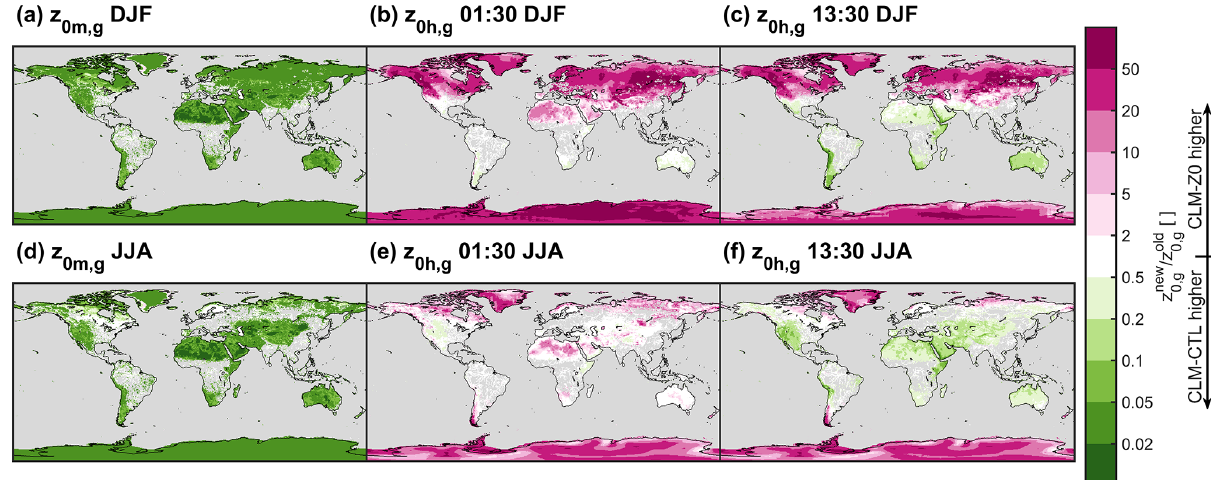
Figure 5. Ratio of new ground surface roughness ( z 0 , g ) divided by old z 0 , g . Panels (a) and (d) show the momentum surface roughness, (b) and (e) surface roughness of scalars at 01:30 local solar time, and (c) and (f) surface roughness of scalars at 13:30 local solar time. (a–c) Boreal winter (DJF) and (d–f) boreal summer